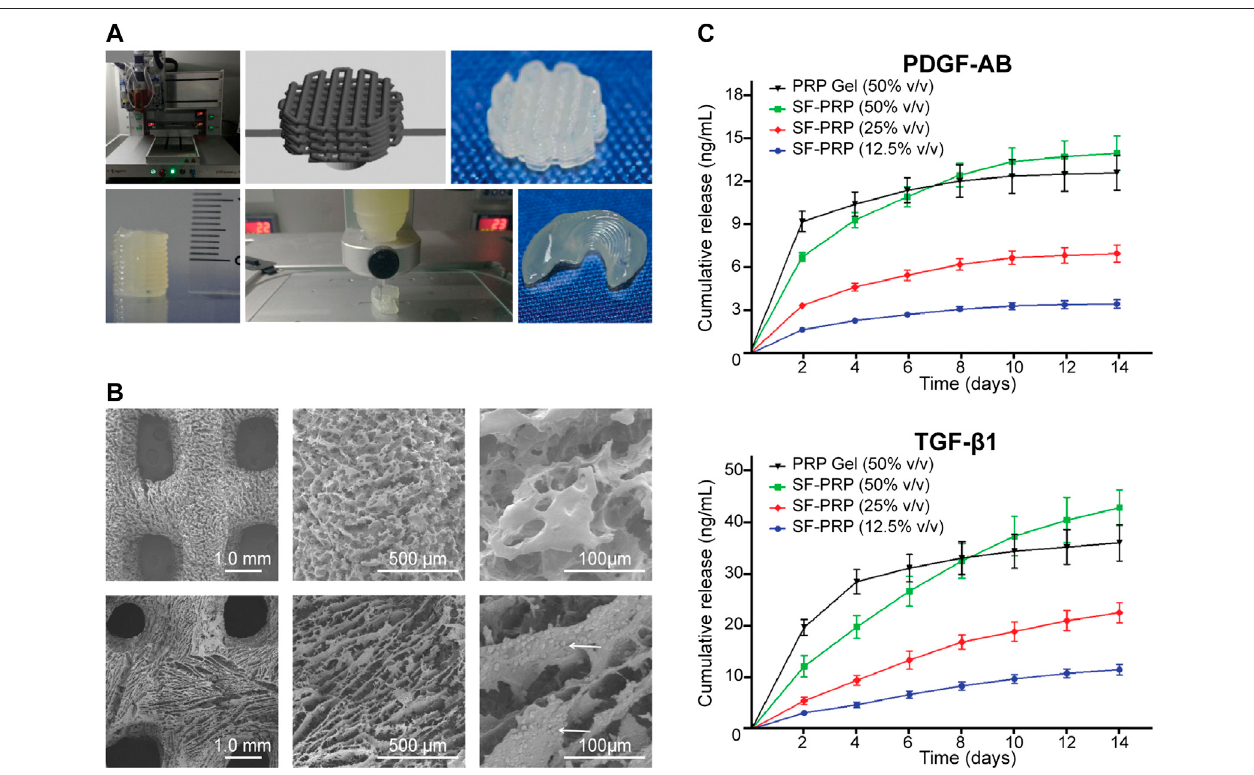
FIGURE 7 | 3D bio-printed scaffolds of SF-PRP bio-inks with high resolution, shape fi delity, and controlled release of GFs. (A) Three-dimensional printing process ofobjectswithvariousshapesanddimensions. (B) Microstructureof3Dprintedscaffolds(whitearrowsindicateplateletsattachedinthescaffold). (C) Sustainedrelease of GFs from SF-PRP hydrogels. Reproduced with permission from Li et al. (2020).